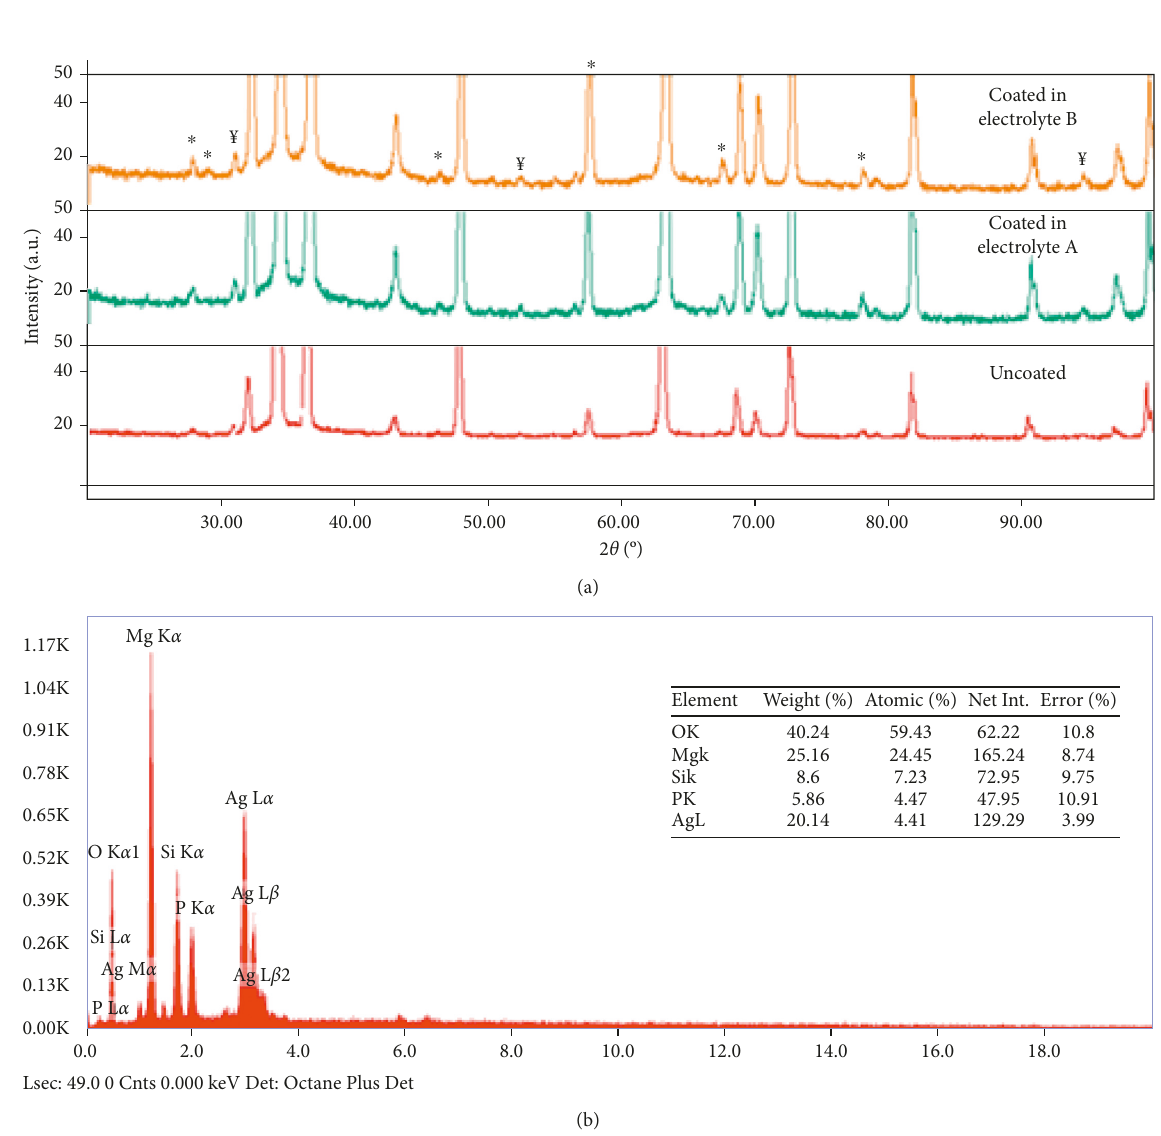
MgO; ¥ Mg 3 (PO 4 (cid:31) (cid:31) ∗